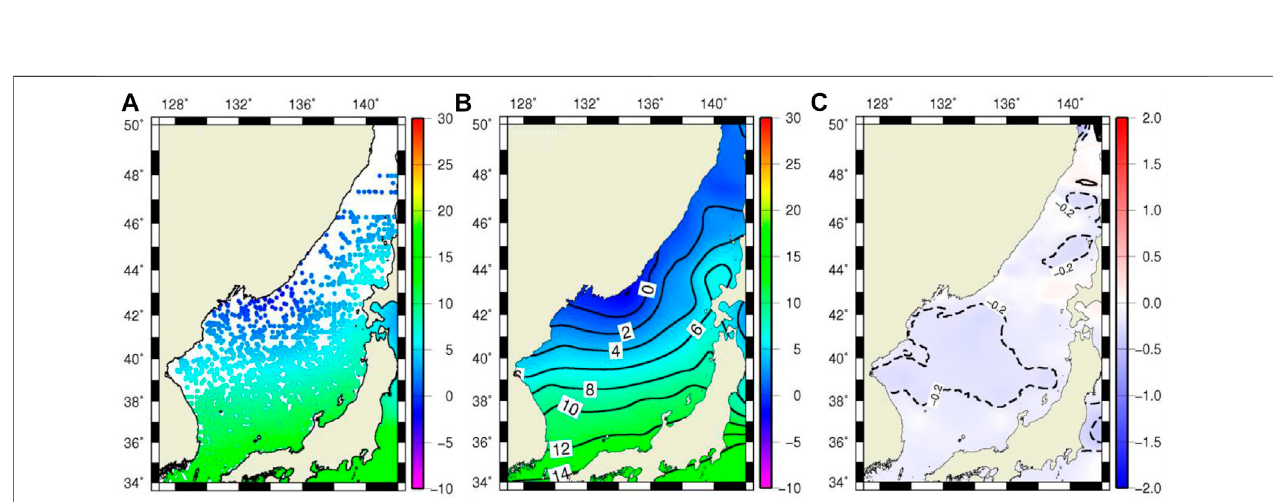
FIGURE6|(A) Dataposition, (B) horizontaltemperature distribution,and (C) meridionaltemperature gradient atthesurfaceinFebruarybyusing0.1 ° WOA13 that was projected to a WOD13